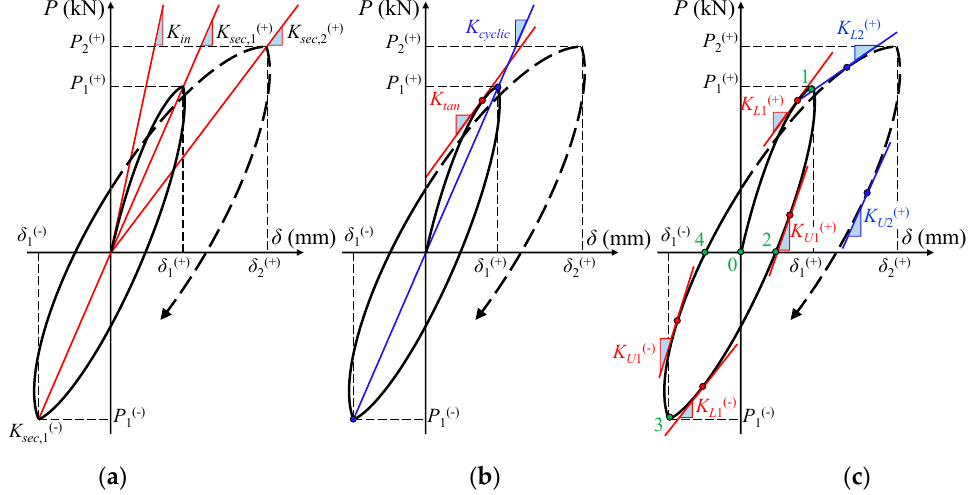
Figure 13. Definitions and variables of the hysteretic loop-loading cycle: ( a ) initial elastic deformation stiffness and secant stiffness; ( b ) tangent and cyclic stiffness; ( c ) loading and unloading stiffness during cyclic reversal imposed load.